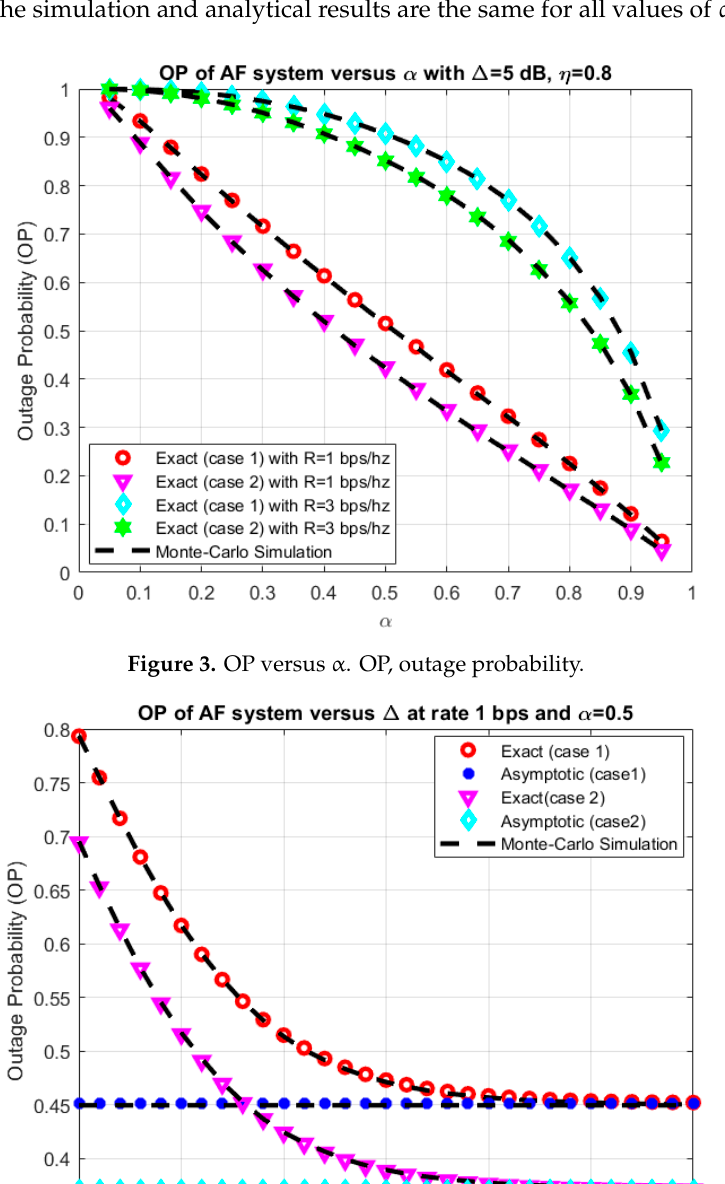
Figure 5. OP versus η . We investigated the influence of the λ 1 = λ 2 = λ on Case 1 of the OP of the model system, as illustrated in Figure 6. Here, we set Δ = {1,5,10} dB, η = 0.8, α = 0.5, and R = 1 bps/Hz. From the results, we saw that the OP fell with the rising λ , and the OP was better with a higher value of Δ . Moreover, the effect of λ 1 ≠ λ 2 on the OP of the model system in connection with λ 1 and λ 2 is presented in Figure 7 with the primary system parameters as Δ = {1,5,10} dB. In this situation, both λ 1 and λ 2 varied from 0 to 4. From the results, we can conclude that the OP of the system falls when λ 1 and λ 2 increase. The